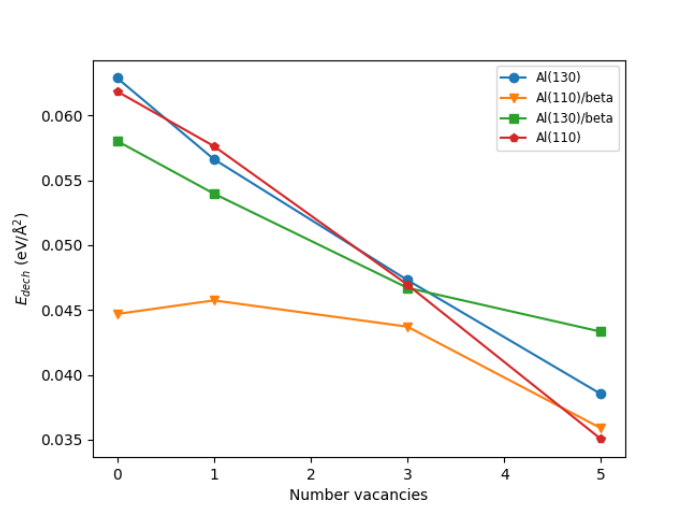
Figure 9. (Colour online) Calculated decohesion energy of the interface models as a function of the number of vacancies added to the decohesion